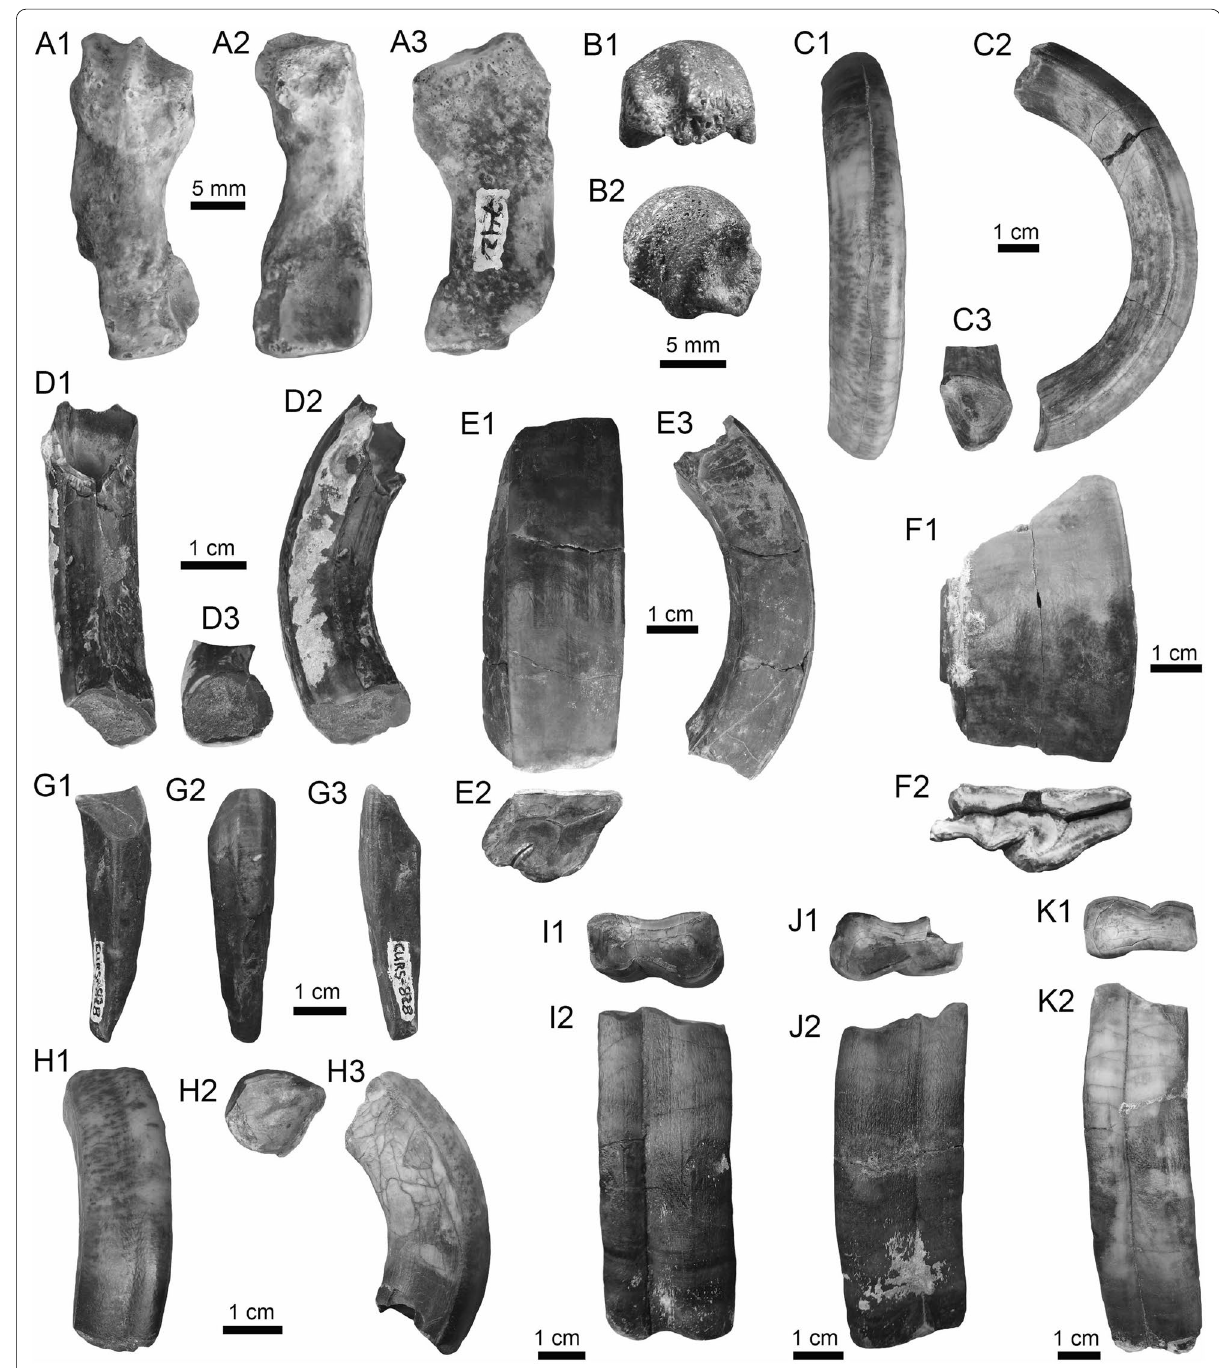
Fig. 24 Litopterna (Proterotheriidae) and Notoungulata (Toxodontidae) from the Vergel Member. A1 – B2 Metacarpal ( A1 – A3 AMU‑CURS‑742) and distal epiphysis of a metacarpal ( B1 , B2 AMU‑CURS‑1189) of indeterminate position assigned to Proterotheriidae indet. C1 – K2 Teeth of Falcontoxodon sp. C1 – D3 Upper incisors: I2 ( C1 – C3 AMU‑CURS‑825) and I1 ( D1 – D3 AMU‑CURS‑1335). E1 – E3 Right upper premolar P4 (AMU‑CURS‑1331). F1 , F2 Right upper molar M1 or M2 (AMU‑CURS‑1346). G1 – H3 Lower incisors i1 or i2 ( G1 – G3 AMU‑CURS‑828 and H1 – H3 AMU‑CURS‑888). I1 – K2 Lower premolars left p4 ( I1 , I2 AMU‑CURS‑831), right p4 ( J1 , J2 AMU‑CURS‑1337), and left p4 ( K1 , K2 AMU‑CURS‑1338). Views: anterior ( A1 ), distal ( B1 , E3 ), disto‑medial ( B2 ), medial ( A2 ), posterior ( A3 ), occlusal ( C3 , D3 , E2 , F2 , H2 , I1 , J1 , K1 ), labial ( E1 , F1 , G2 , H1 , I2 , J2 , K2 ), lingual ( D1 , G1 ), mesiolingual ( C2 ), and mesial ( C1 , D2 , G3 , H3